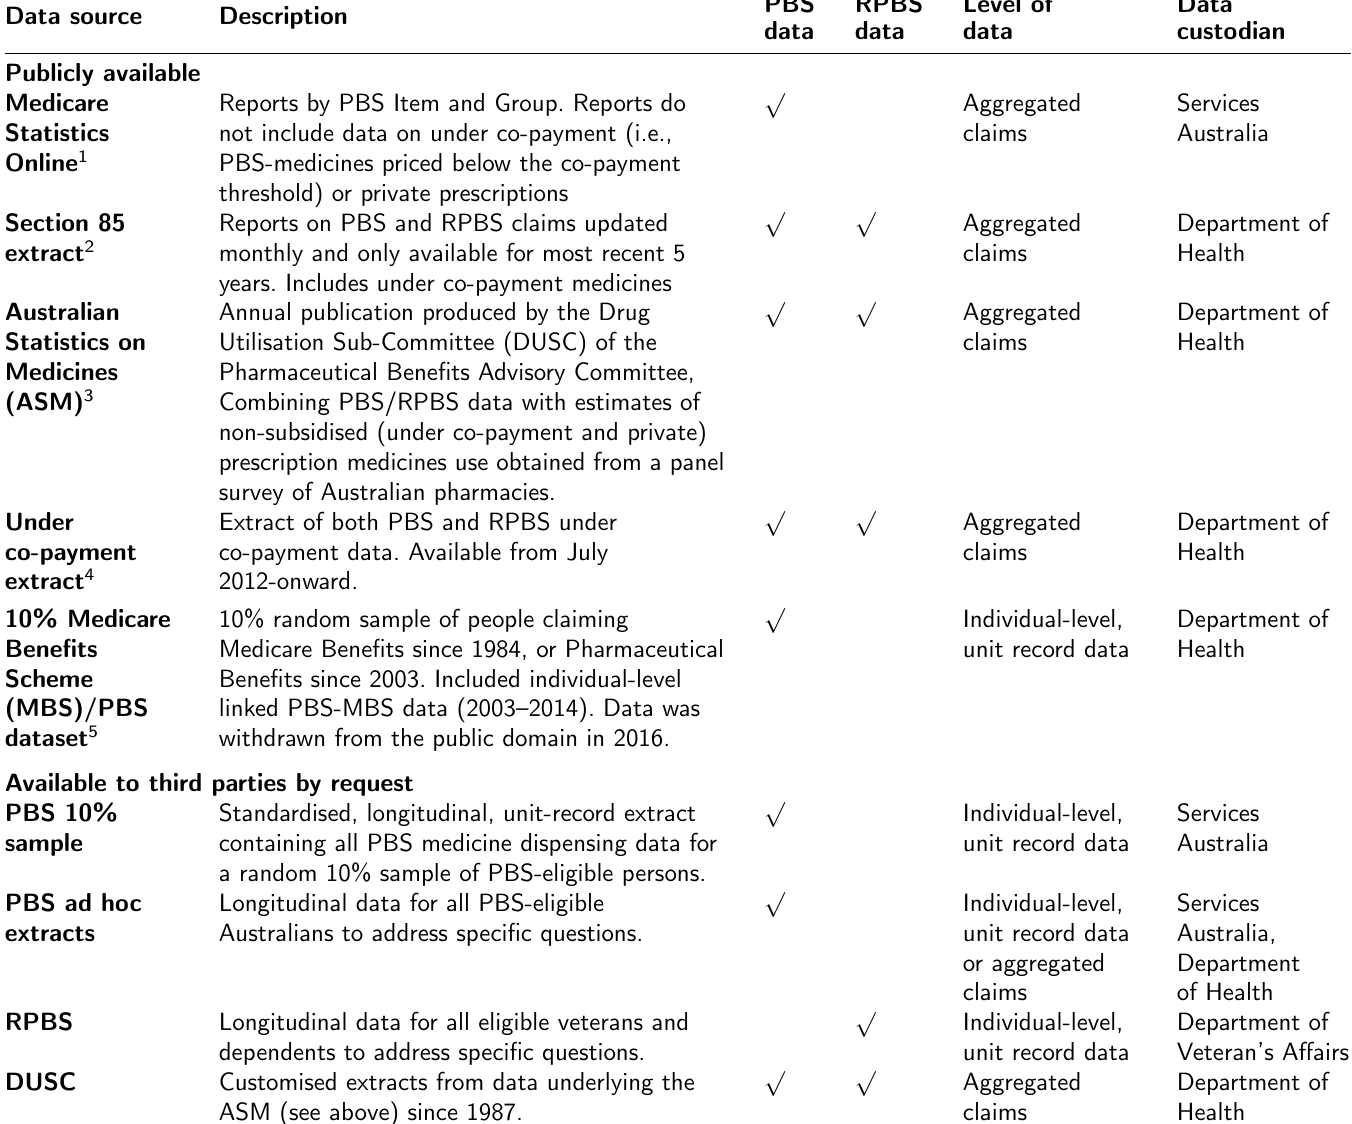
Supplementary Table 1: Sources of dispensing claims data available to third parties for monitoring, surveillance, and